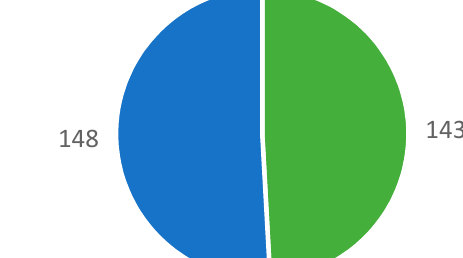
Figure 1. Count of Farmers by Cover Crop Use.